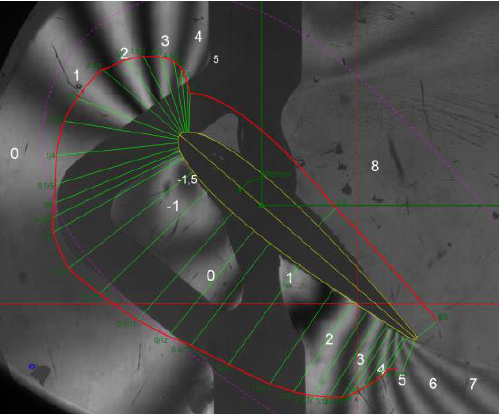
Fig. 3. The cut of GUI of